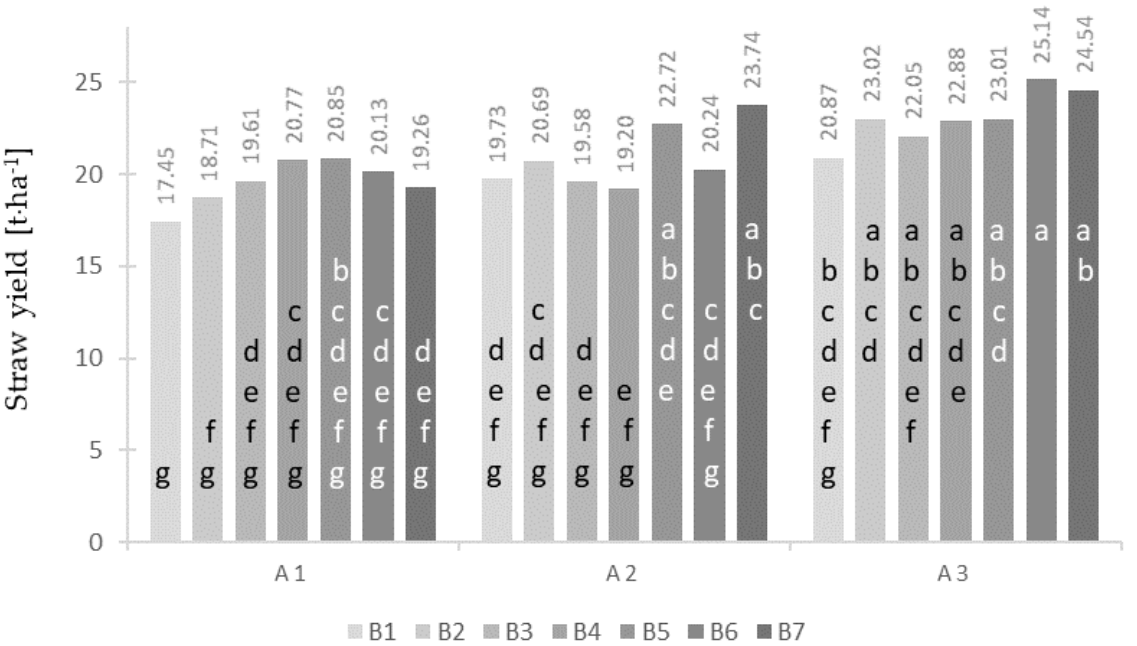
Figure 3. Average stover yield values [t · ha − 1 ] for the combination of cultivar (A) and fertilizer (B). Values marked with the same letter do not differ significantly ( p = 0.0052).